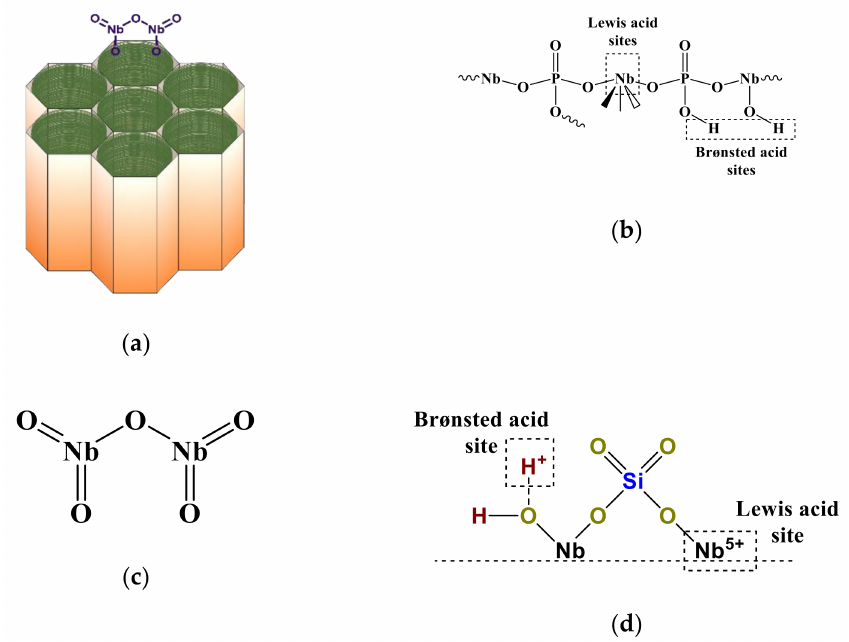
Figure 10. ( a ) Nb 2 O 5 supported on MCM-41; ( b ) Niobium phosphate; ( c ) Niobium oxide; and ( d ) sulfated Niobium oxide (adapted from